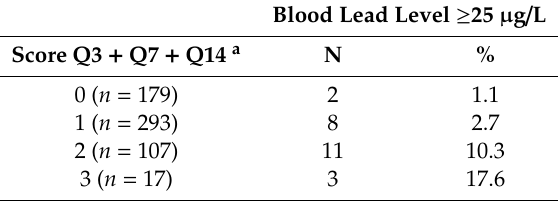
Table 5. Calculation of an overall score from exposure factors significantly associated with high blood lead levels ( n =